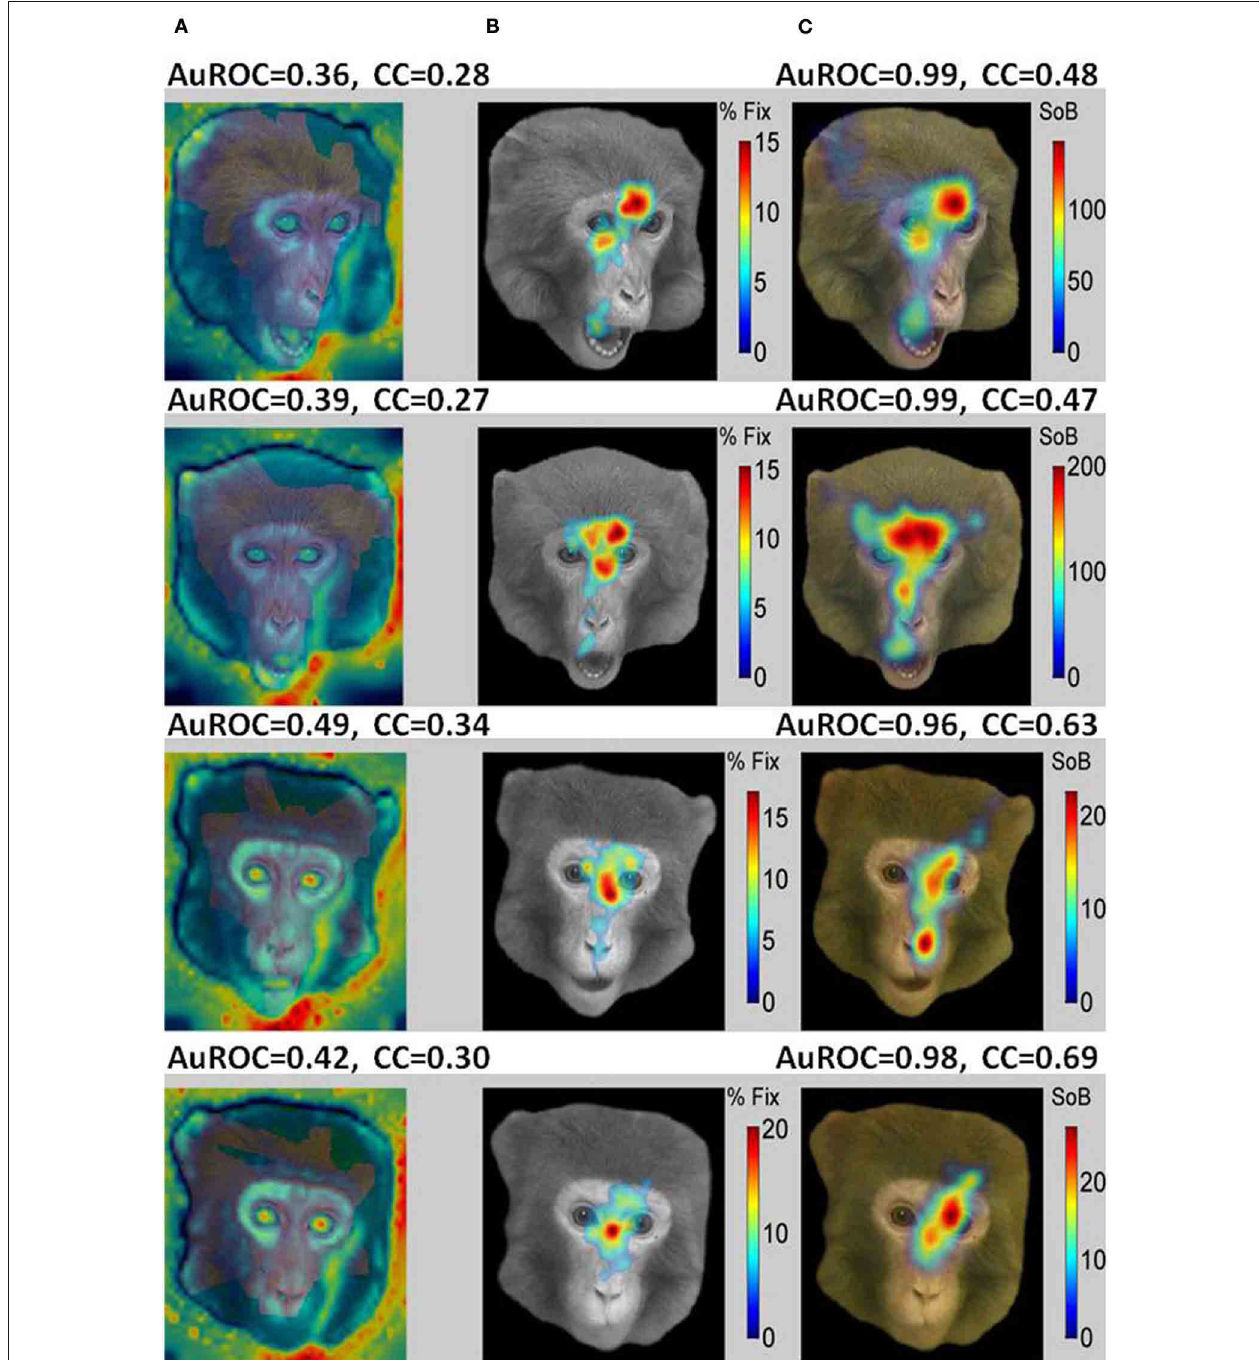
FIGURE 9 | A saliency model generated from the burst firing of ensemble of cells in the primates amygdala (ASM) is an excellent predictor of fixations on faces while bottom-up visual saliency (VSM) fails. (A) Examples of faces portraying different facial expressions seen by the monkeys with VSM overlaid on top. (B) Summary Fixation HotSpot maps for multiple presentations of the same face emphasizing pixels that received significantly longer fixations across repetitions of the same face. (C) Amygdala Saliency model (ASM) generated from the firing of ensembles of cells in the amygdala. The numbers